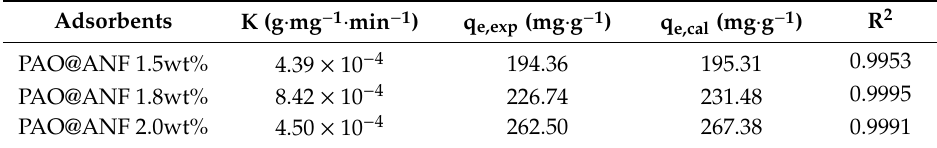
Table 1. The adsorption kinetic fitting parameters of pseudo-second-order kinetic model with the